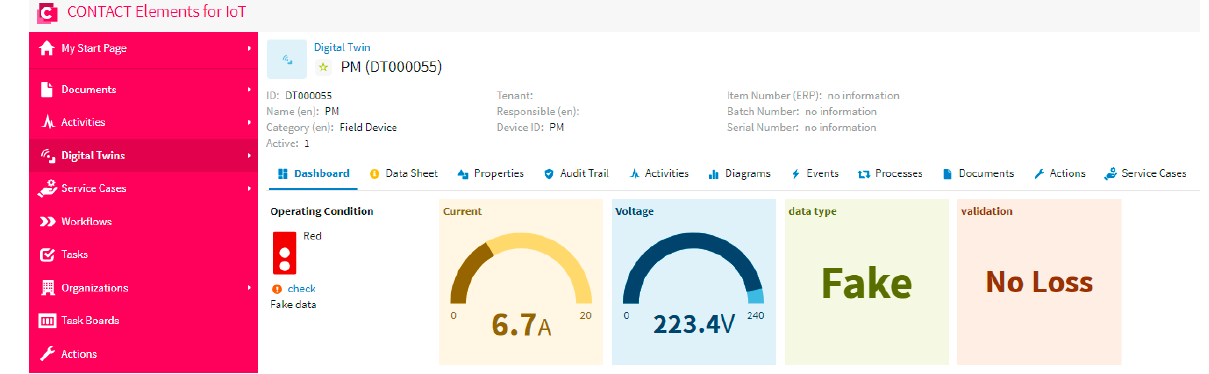
Figure 11. The dashboard of the IoT platform results in a case of fake data and no loss testing.